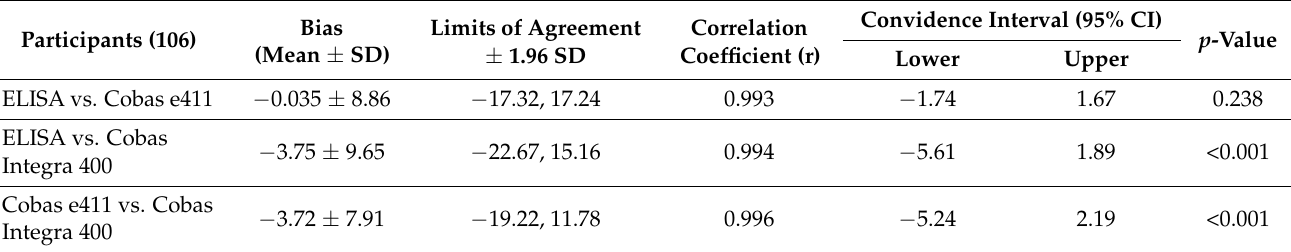
Table 5. Bias, limits of agreement, and correlation coefficients of